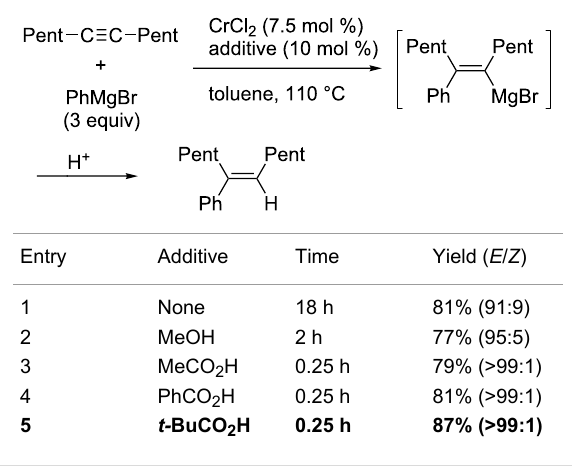
Table 5: Acceleration effect of additive on chromium-catalyzed aryl-